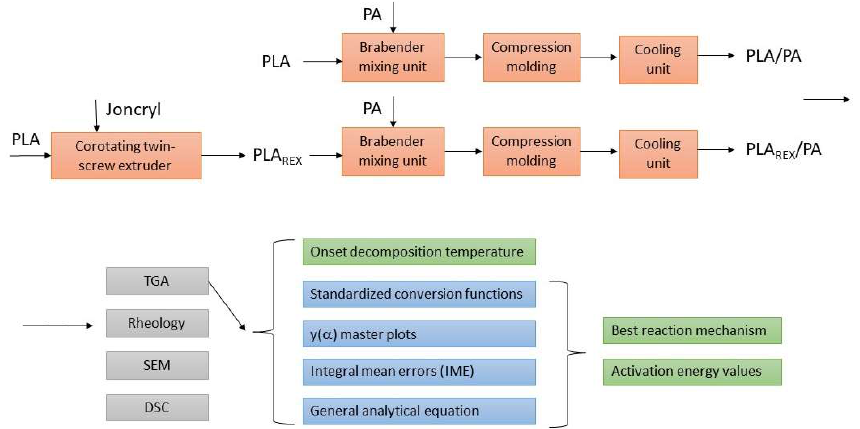
Figure 1. Experimental procedure used to obtain and characterize PLA/PA and PLA REX /PA bio- blends.